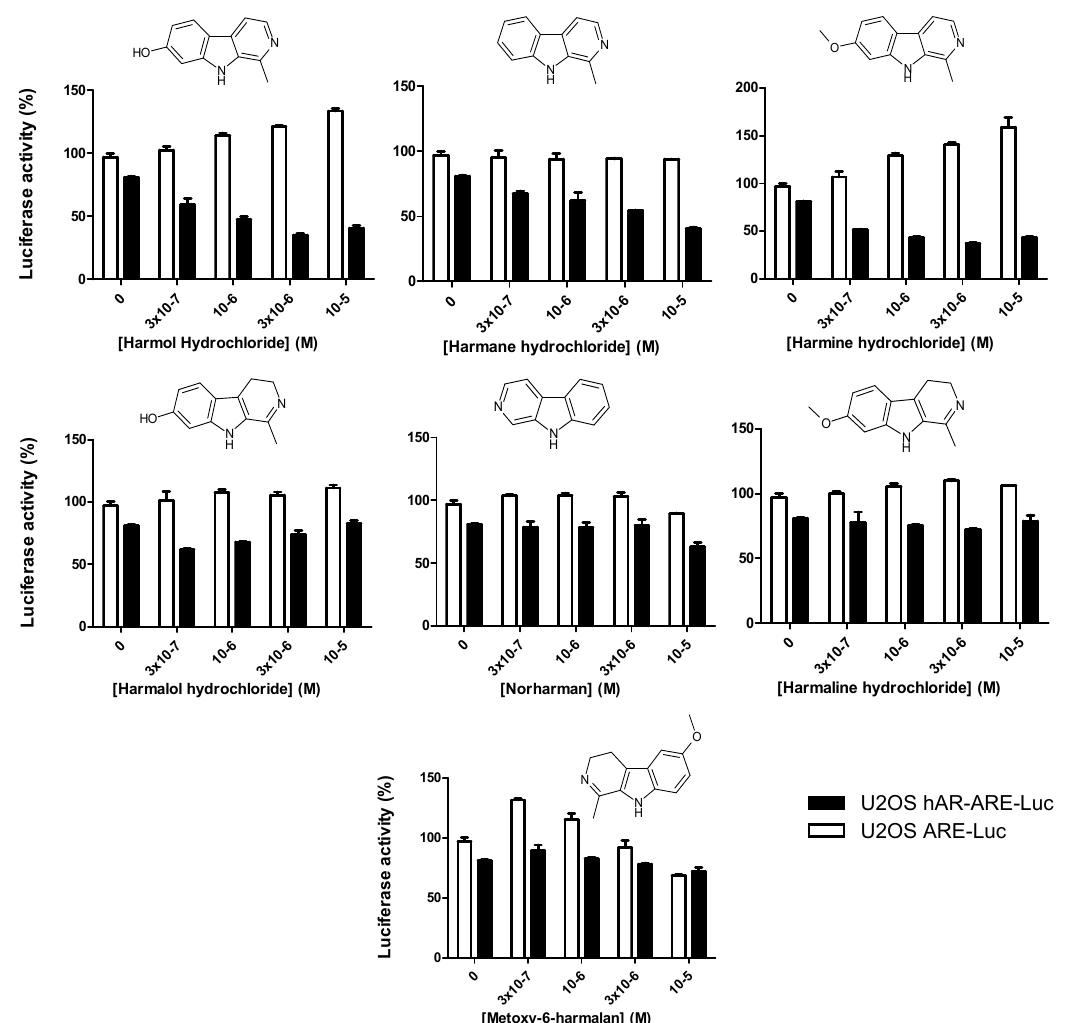
Figure 2. Results of the high throughput screening for harmol hydrochloride and its beta-carboline derivatives. The high throughput assays were performed in duplicate as described in the Materials and Methods section in the presence of 1 nM R1881. The effects of harmol, harmane, harmine, harmalol, norharman, harmaline, and metoxy-6-harmalan used at 0.3, 1, 3, and 10 µM on the luciferase activity (% as compared to cells treated with 100 nM R1881) in U2OS-hAR-ARE-Luc (black bars) and U2OS-androgen response elements (ARE)-Luc control cells (white bars) are shown. The chemical structures of each compound are presented above each graph.